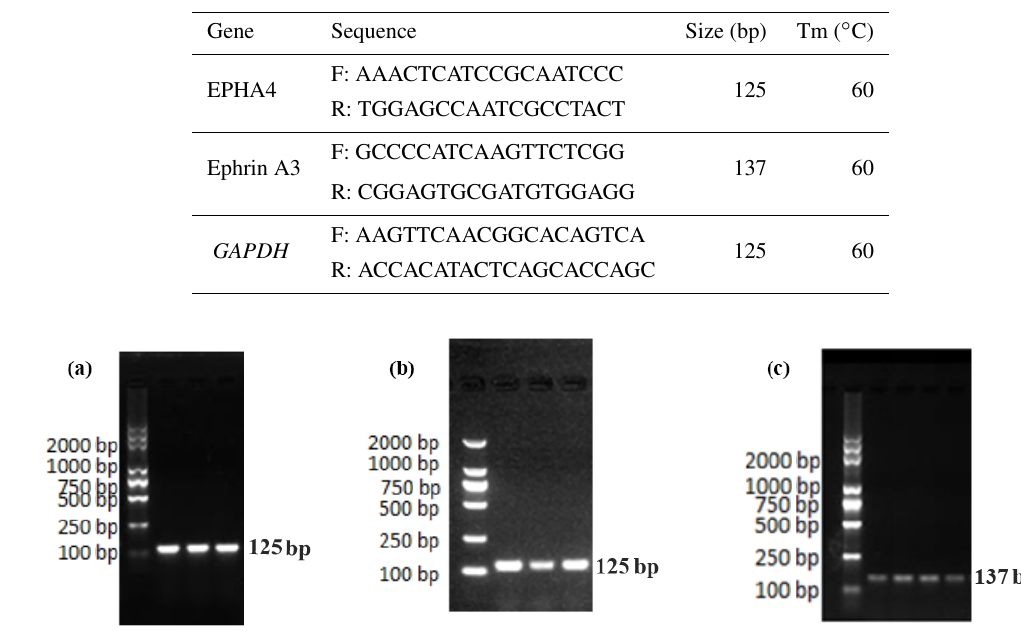
difference between the B30d group and either B1d or E120d groups ( P> 0 .